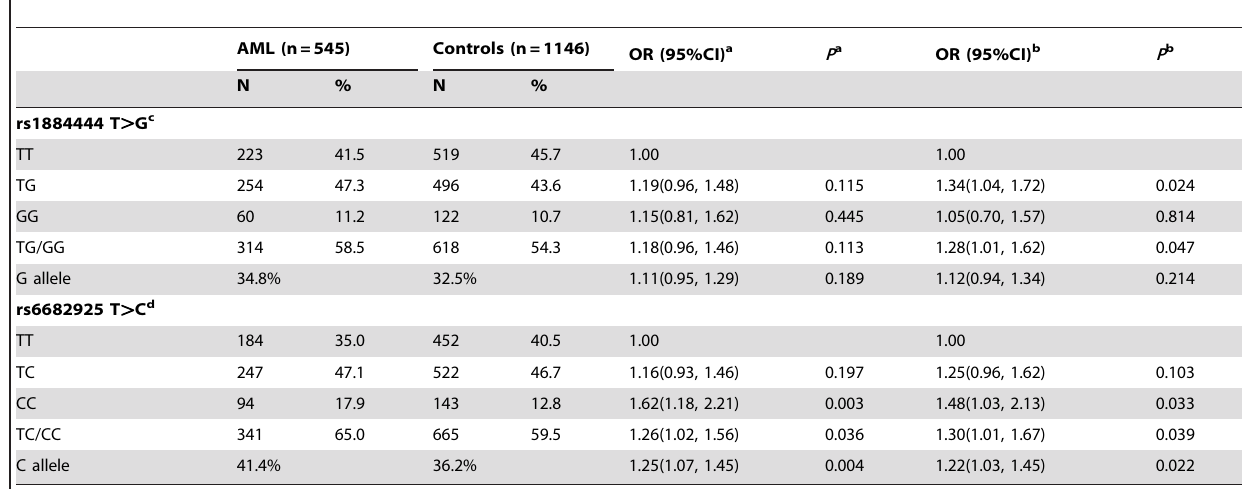
Table 2. Distribution of Alleles and Genotypes of IL-23R Variants and Their Association with AML Risk.